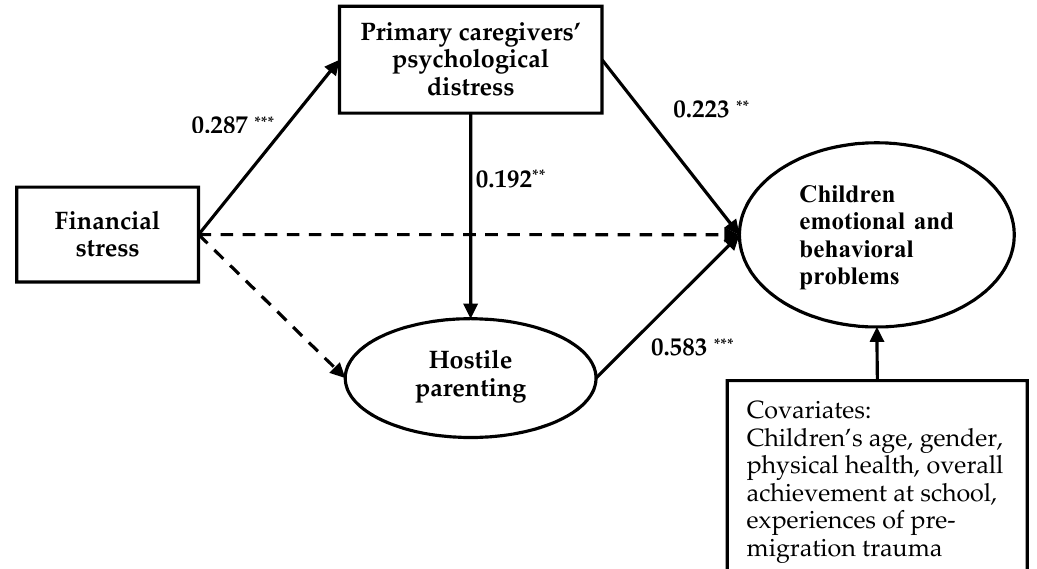
Figure 2. Basic Family Stress Model (FSM). Note. ** p < 0.01, *** p < 0.001. Coe ffi cients are standardized path coe ffi cients. The solid lines represent significant paths ( p < 0.05). The dashed lines represent non-significant paths. Children’s age, gender, physical health, overall achievement at school, and experiences of pre-migration trauma are included as covariates.